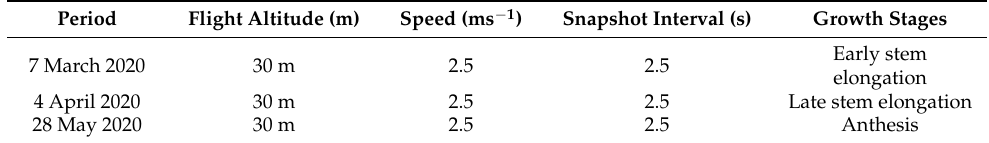
Table 4. Flight details for the automated unmanned aerial vehicle imagery system during